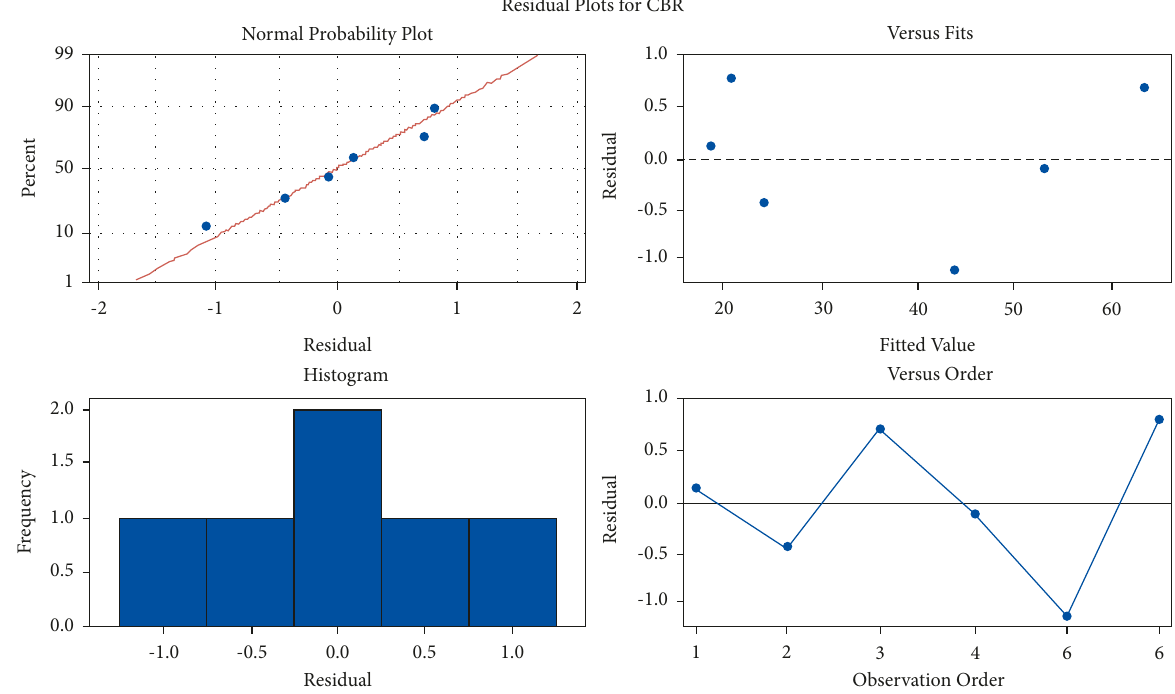
Figure 10: Residual plots for the MLR